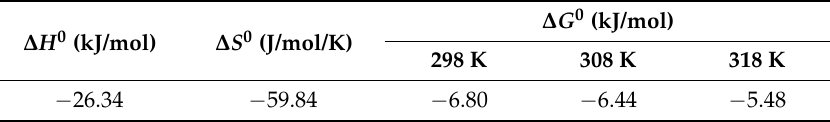
Table 5. Thermodynamic parameters for Hg(II) adsorption onto CoFe 2 O 4 @SiO 2 –NH 2